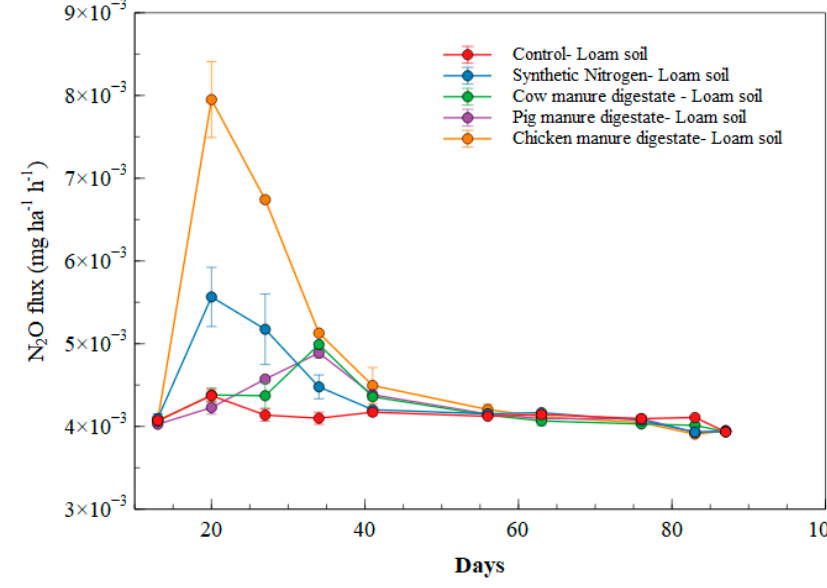
Figure 4. N 2 O emissions in loam soil.